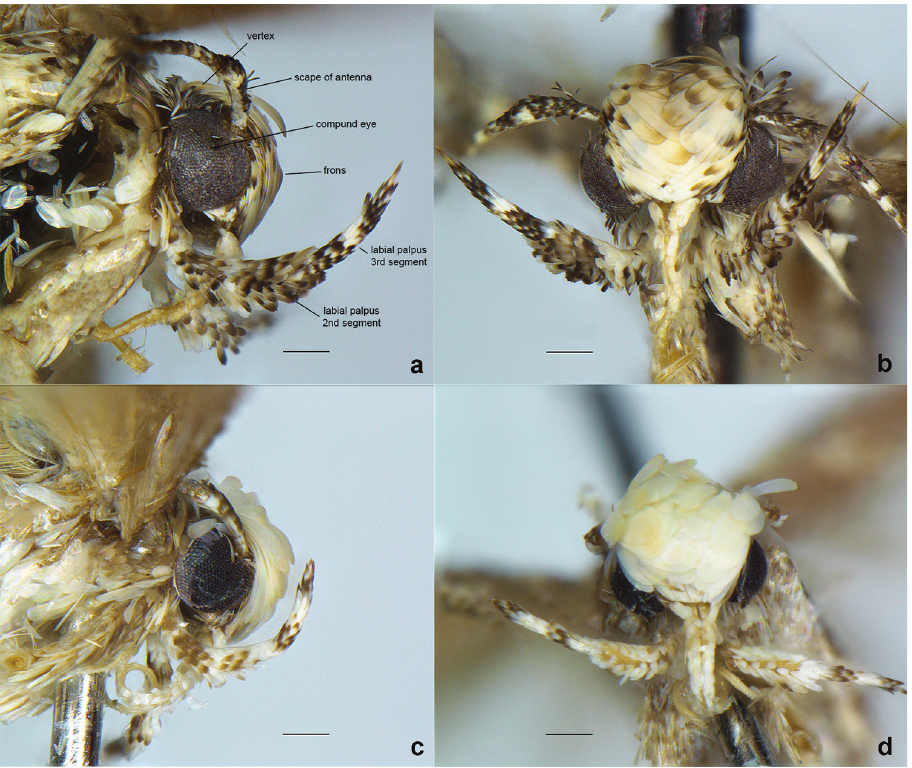
Figure 2. Close up of the head of male Neopalpa species. a, b N. neonata (LACMENT326885, Mexico: Baja California) c, d N. donaldtrumpi sp. n., holotype (UCBMEP0201628, CA: Imperial County). Left: lateral aspect, right: frontal aspect. Scale bar 1